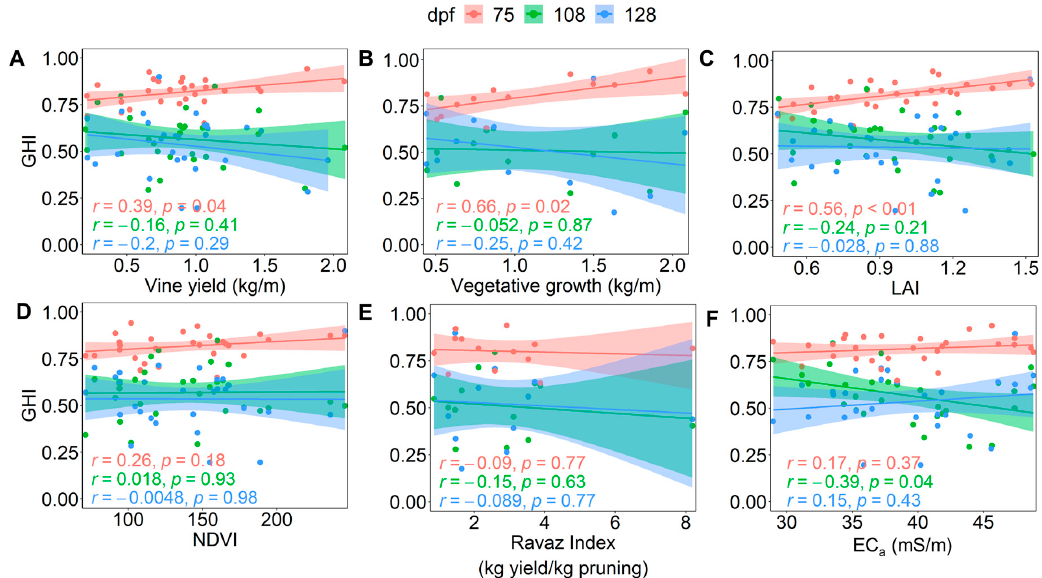
Figure 9. Relationship of vine GHI(3) scores with scaled ( A ) vine yield, ( B ) vegetative growth, ( C ) leaf area index (LAI), ( D ) normalised difference vegetation index (NDVI), ( E ) Ravaz index, and ( F ) soil electrical conductivity (EC a ) across the Commercial Block for different sampling dates (75, 108 and 128 dpf) in season 2020/2021. Linear fits (–) are graphed to aid visualisation of the relationship between variables, with Pearson correlation coefficient (r) and p -value indicating the strength and signi fi cance of the relationship.